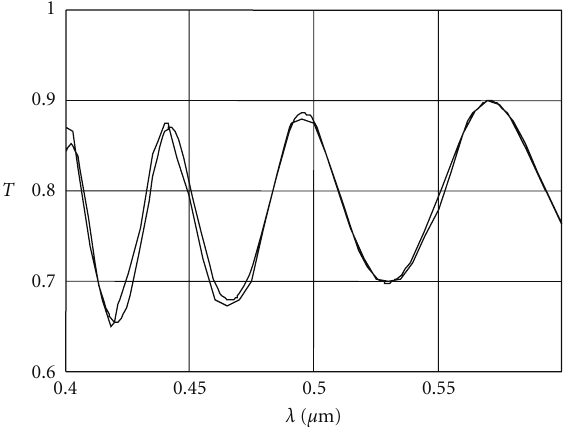
Figure 7: Transmittance spectrum of a thin dielectric film ( d 1 = 1 μ m) with small optical losses ( n 1 = 2 . 21, k 1 = 0 . 01) on a transparent substrate ( n 2 = 1 . 472, k 2 = 0) computed for the 3M structure (solid line) and 4M structure (dashed line); a solid thin curve is calculated from (1) and (3) by using the same numerical values.